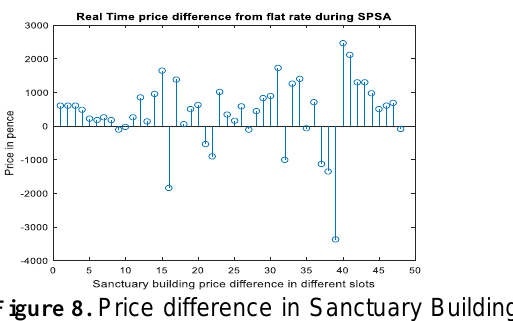
Figure 8. Price difference in Sanctuary Building from flat rate in different slots